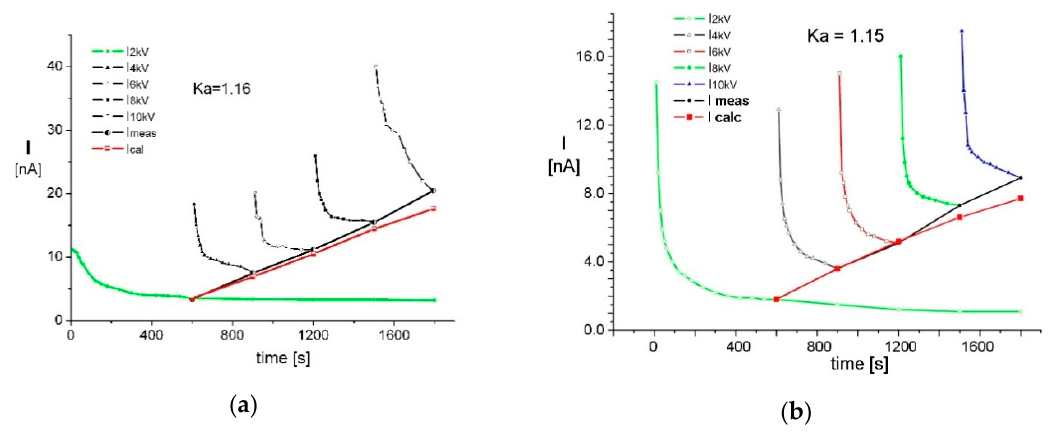
Figure 6. The SVM test chart of CTKF 145 kV bushing insulation after ( a ) 10 years of operation; ( b ) an additional 740 h of aging after deinstallation [16].